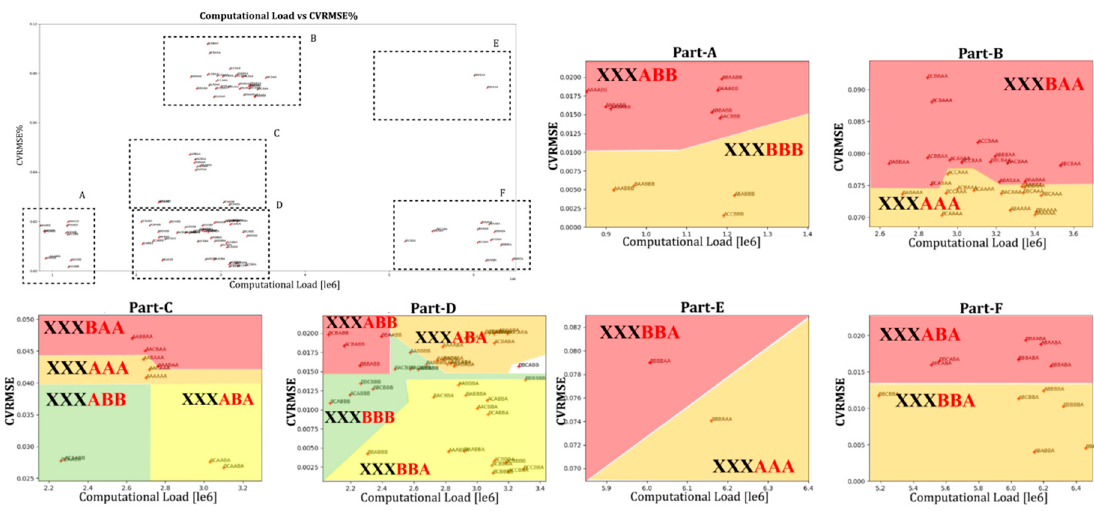
Figure 7. Computational load against CVRMSE (zone mean air